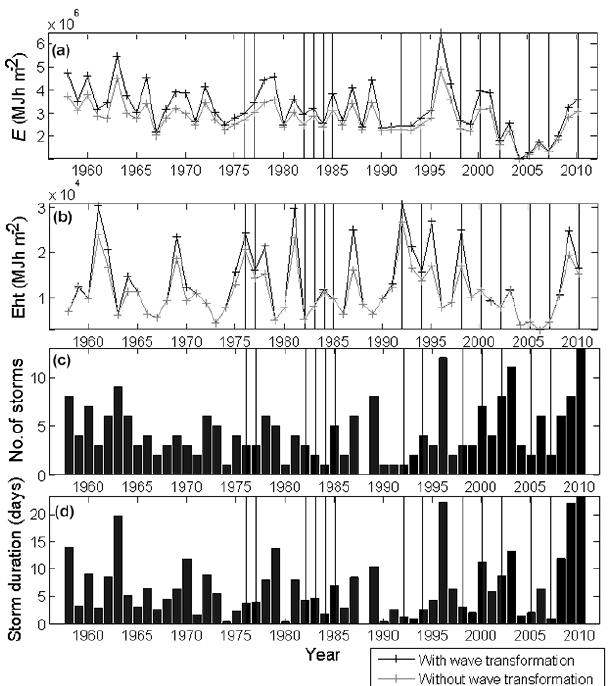
Figure 4. Cumulative energy ( E C ) and wave erosivity (Er C ), mean energy ( E M ) and energy at high tide (Eht M ), peak energy ( E P ) and energy at high tide (Eht P ) and storm duration and frequency for the periods between sets of